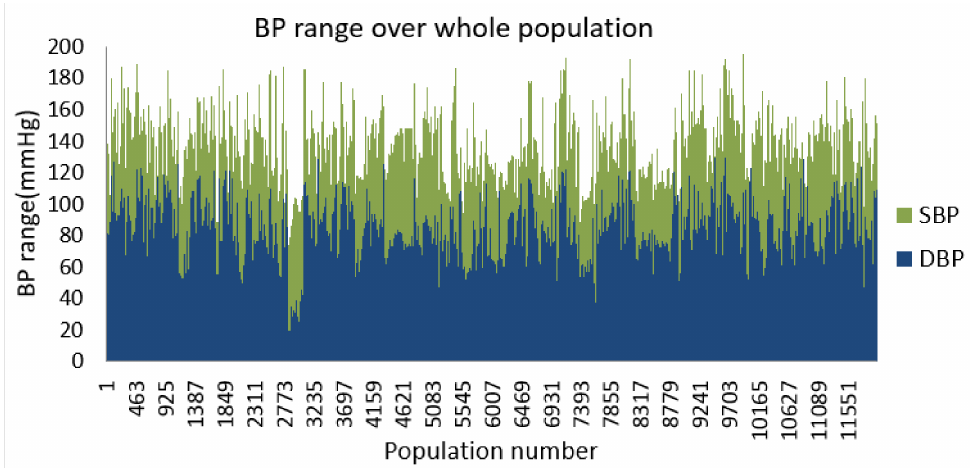
Figure 11. The range of blood pressure over all populations.